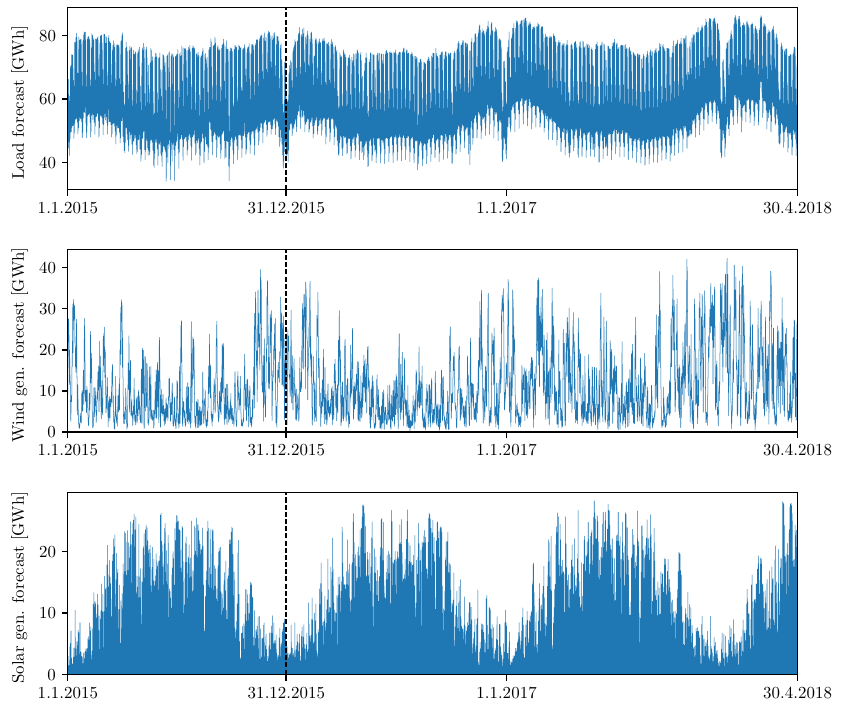
Figure 2. Three forward-looking fundamental time-series: system-wide load forecasts ( top ), wind generation forecasts ( middle ) and solar generation forecasts ( bottom ) for the period from 1 January 2015 to 30 April 2018. All three are published on day d 1 and concern the 24 h of day d . As in Figure 1, − the vertical dashed lines mark the beginning of the 852-day long out-of-sample test